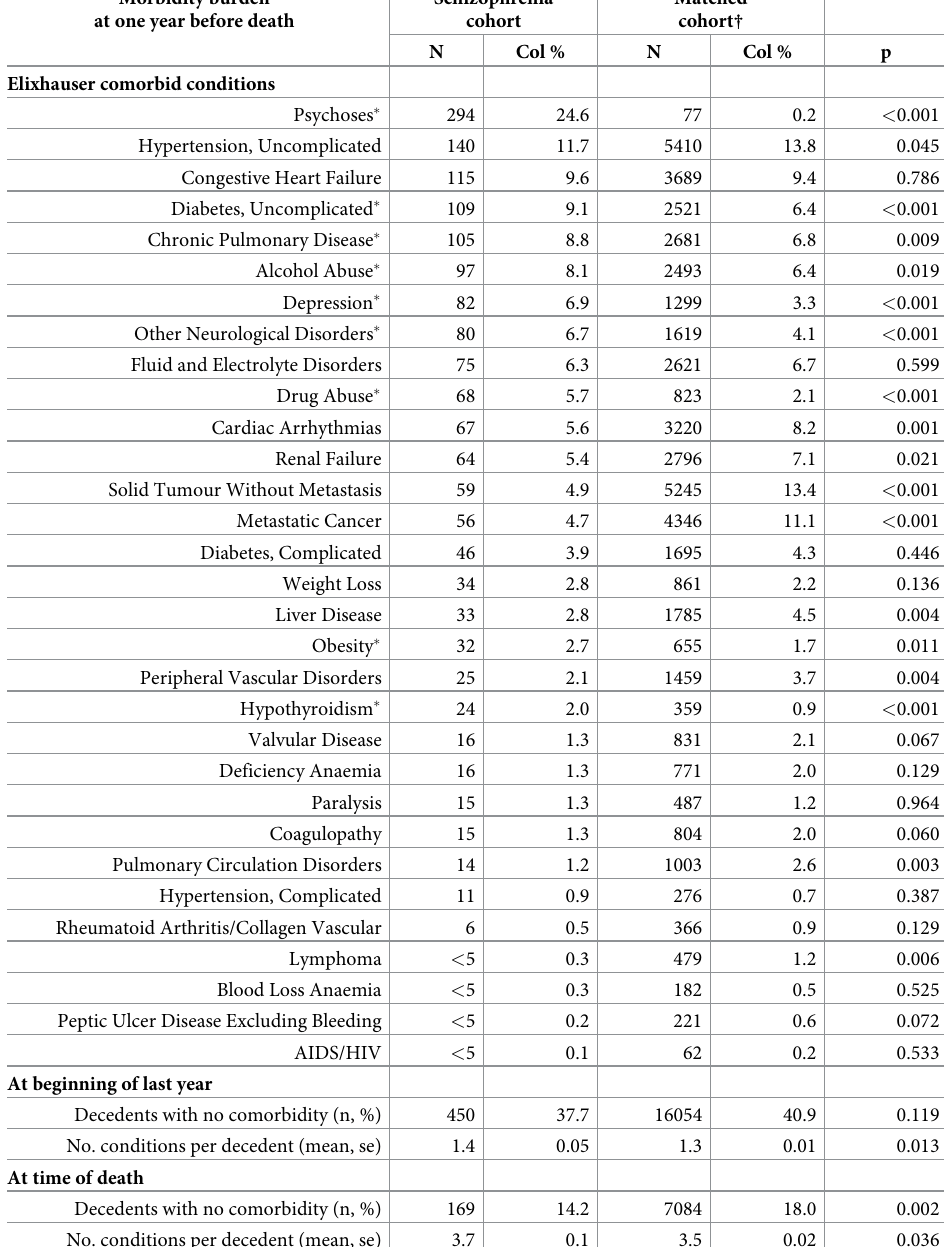
Table 3. The number of decedents with specific morbid conditions at one year before death in the schizophrenia and matched cohorts estimated from 5-year look back of hospital records. Morbidity burden at one year before